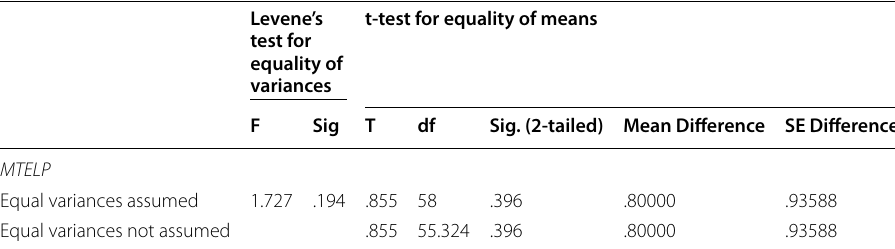
Table 3 Independent Samples Test